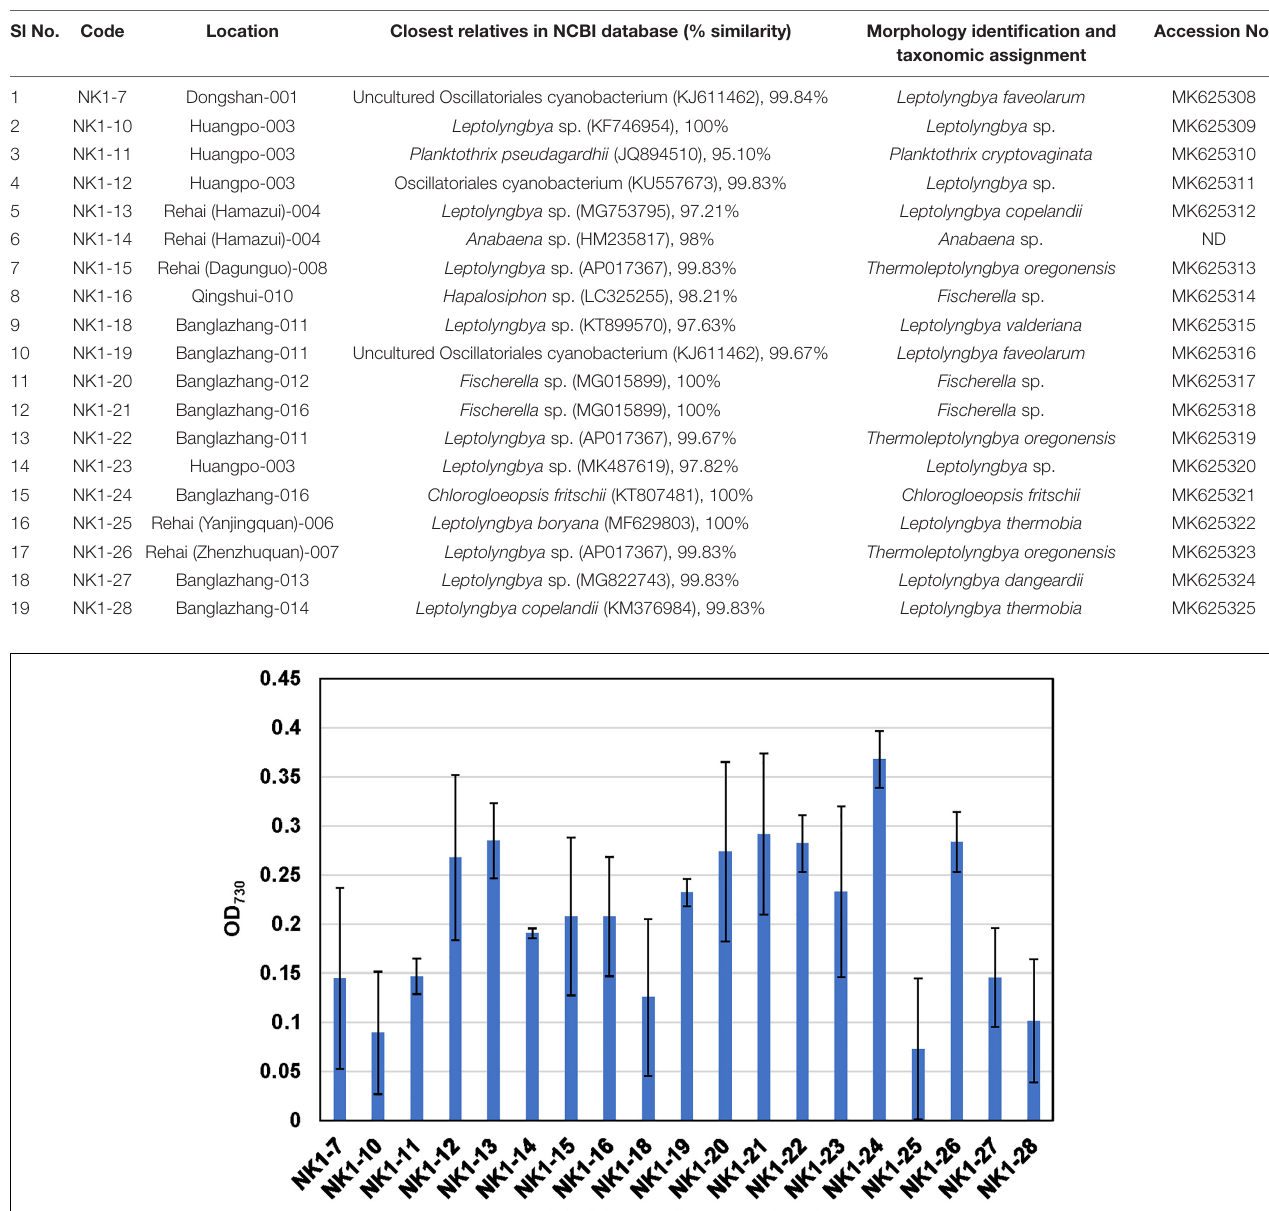
TABLE 3 | List of identified cyanobacterial isolates from representative hot springs of Yunnan Province, China. Sl No. Code